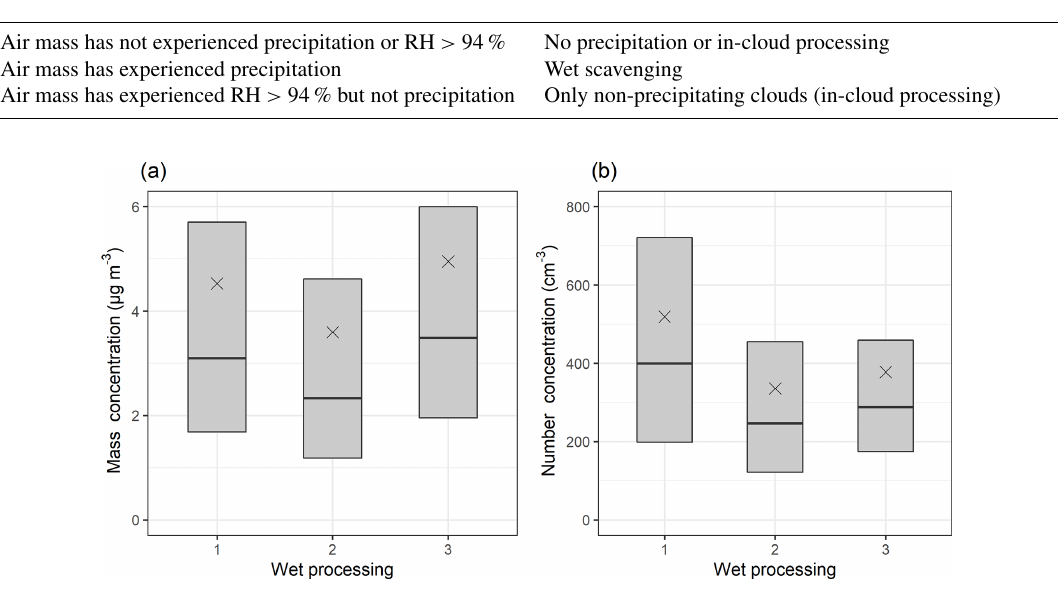
Figure 5. Median (black horizontal lines), mean (black crosses), and 25th–75th percentiles (boxes) for accumulation mode ( d p = 100– 1000nm) particle mass (a) and number (b) concentration for wet processing groups described in Table 1. The figure includes DMPS data between January 2005 and August